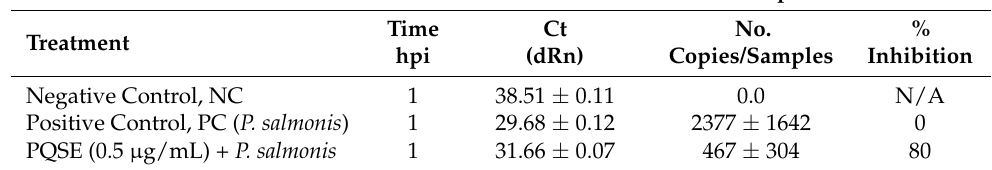
Table 2. Absolute quantification of P. salmonis DNA at 1 hpi and 72 hpi in SHK-1 cells. The pre- treatment of SHK-1 cells with PQSE (0.5 µ g/mL) for 4 h significantly ( p < 0.05) reduced the intracellu- lar proliferation of P. salmonis (by 80% at 1 hpi (Panel A) and 76% at 72 hpi) as measured by absolute quantification of bacterial DNA. Panel A—Intracellular Proliferation of P. salmonis at 1